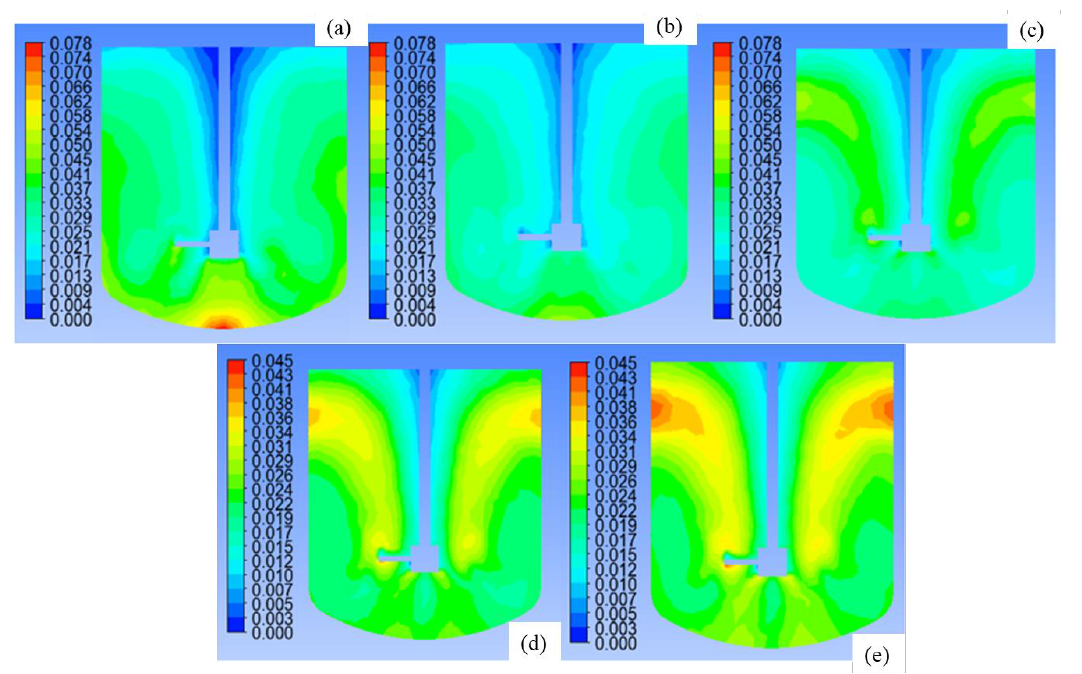
Figure 5. Solid phase volume fraction distribution at steady state. ( a ) N = 200 rpm; ( b ) N = 300 rpm; ( c ) N = 400 rpm; ( d ) N = 500 rpm; ( e ) N = 600 rpm.